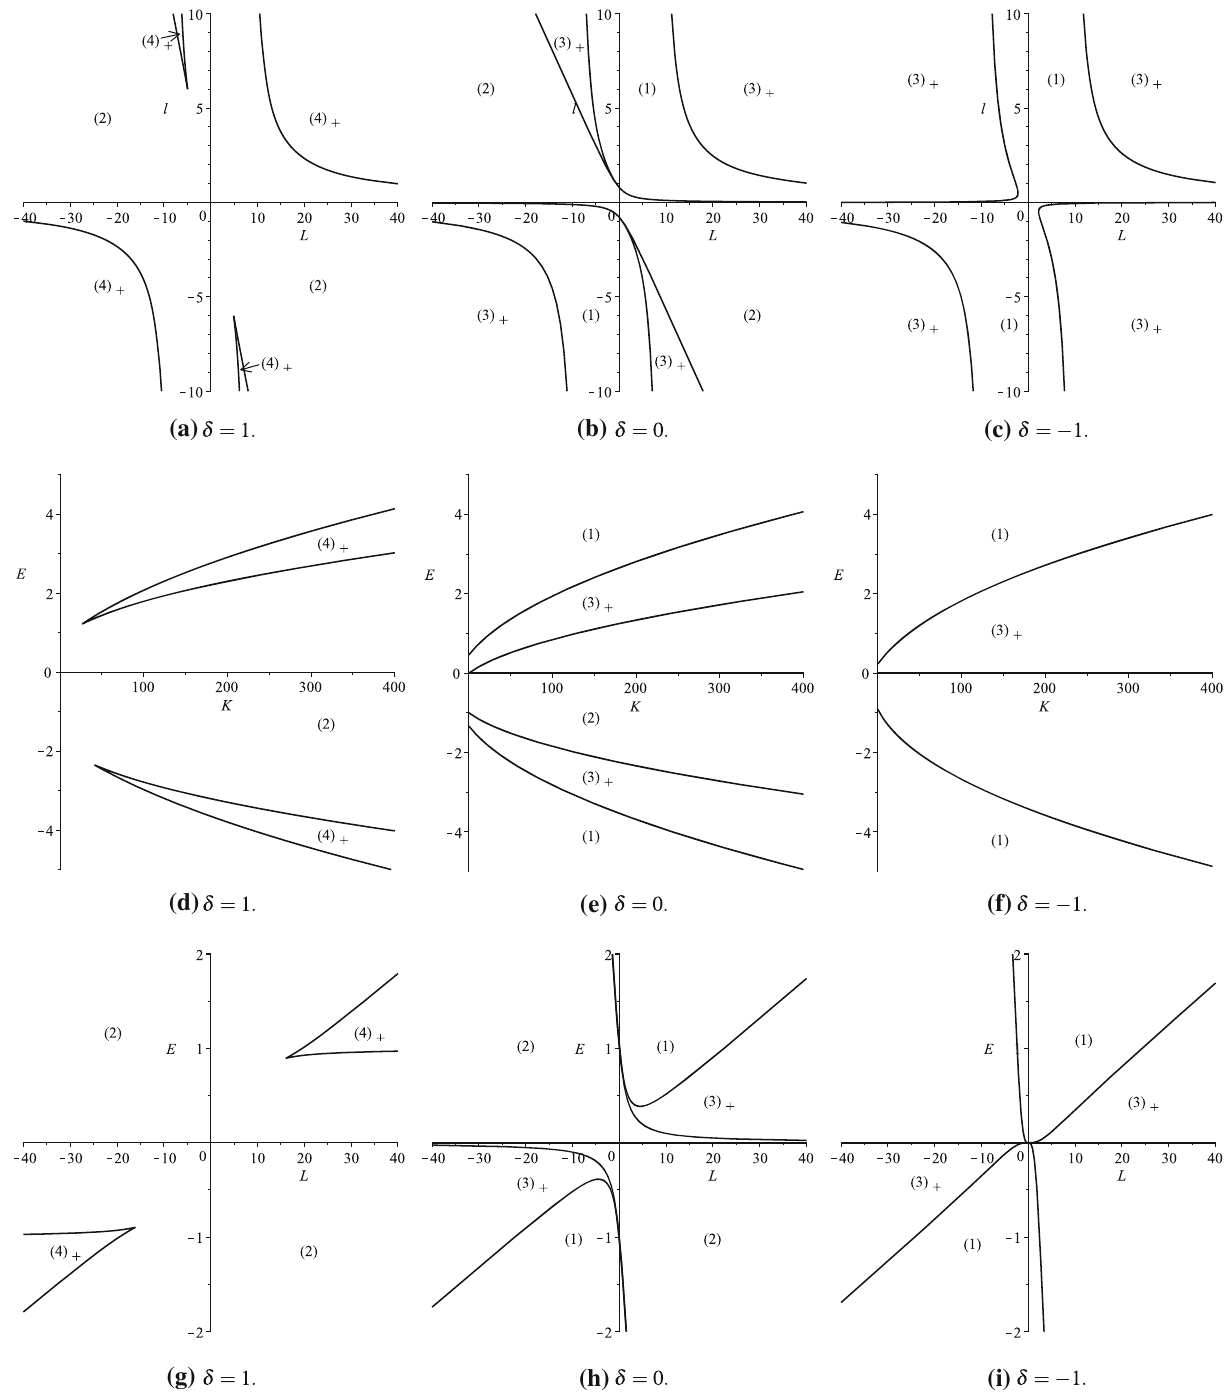
Fig. 2 Parametric L - l , K - E , and L - E diagrams for varying mass parameter δ and parameters E = 1 . 8 , K = 8 ( a – c ), L = 4 , l = 4 ( d – f ), and l = 1 , K = 4 ( g – i ), showing regions (1)–(4). This marks the number of positive zeros of the polynomial P in Eq. (25), i.e., lines corresponding to transitions of negative roots to complex ones are not